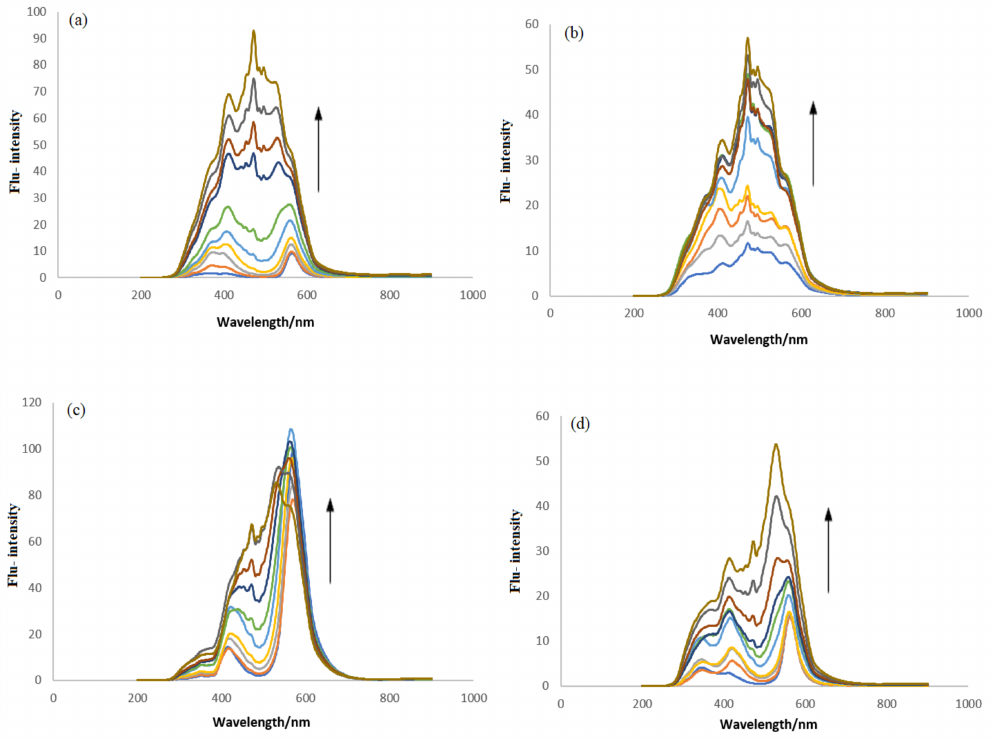
Figure 8. Flu-responses of ( a ) IST-01, ( b ) IST-02, ( c ) IST-03, and ( d ) IST-04 before and after DNA titrations. Arrow direction indicates the enhancement in the peak intensity of tested compounds.